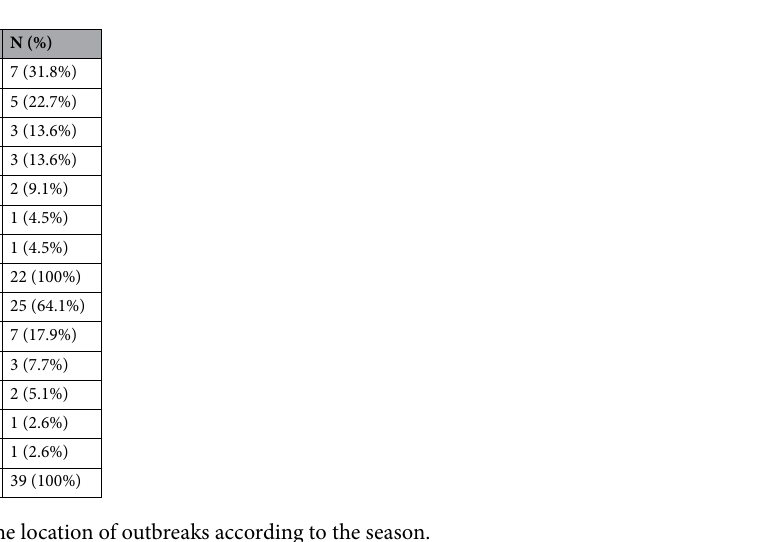
Thirty-nine of the 61 outbreaks (63.9%) occurred in the winter months. Table 2 shows the distribution of outbreaks caused by norovirus in the warm and winter season according to the location of the outbreak. The characteristics of GII.2 and GII.4 outbreaks are shown in Table 3. Norovirus GII.2 outbreaks were more frequently detected in schools or summer camps (66.7%) and norovirus GII.4 outbreaks in nursing homes (91.7%) ( p = 0.01). The mode of transmission was person-to-person in 55.6% of norovirus GII.2 outbreaks and 100% in norovirus GII.4 outbreaks ( p = 0.02): 91.7% of norovirus GII.4 outbreaks and 44.4% of norovirus GII.2 outbreaks occurred in the winter season ( p = 0.05). A total of 809 surveys of symptomatic patients were obtained in the 61 outbreaks: 537 (66.8%) were female and 267 (33.2%) male. The median age was 41 years (range: 6 months–105 years). Information on the duration of symptoms was available in 497 surveys, the median duration of symptoms was 1 day (range: 0–30 days); 21.7% (108/497) of those affected had symptoms of < 24 h of evolution, 30.6% (152/497) of one day of evolution, 21.7% (108/497) of 2 days of evolution, 14.1% (70/497) of 3 days of evolution and 11.9% (59/497) had a dura- tion of ≥ 4 days. The most frequent symptoms were vomiting (80.1%), diarrhea (74%), abdominal pain (62.4%), nausea (55.7%) and fever (27.6%). Information on required oral fluid replacement, intravenous fluid replace- ment and hospital admission was available in 397, 361 and 752 surveys respectively, 23.4% (93/397) required oral fluid replacement, 4.7% (17/361) intravenous fluid replacement and 2.5% (19/752) hospital admission. No cases were admitted to ICU nor died. Ninety-three people were affected in GII.2 outbreaks and 94 in GII.4 outbreaks. GII.4 outbreaks had a higher frequency of women than GII.2 outbreaks (79.8% vs. 59.8), although the differences were not statistically signifi- cant in the multivariate analysis (Table 4). The median age was 15 years (range: 1–95 years) in those affected by GII.2 outbreaks and 86 years (range: 0–100 years) in those affected by GII.4 outbreaks ( p < 0.001). Fever, nau- sea, abdominal pain, headaches, chills, and myalgia were observed more frequently in people affected by GII.2